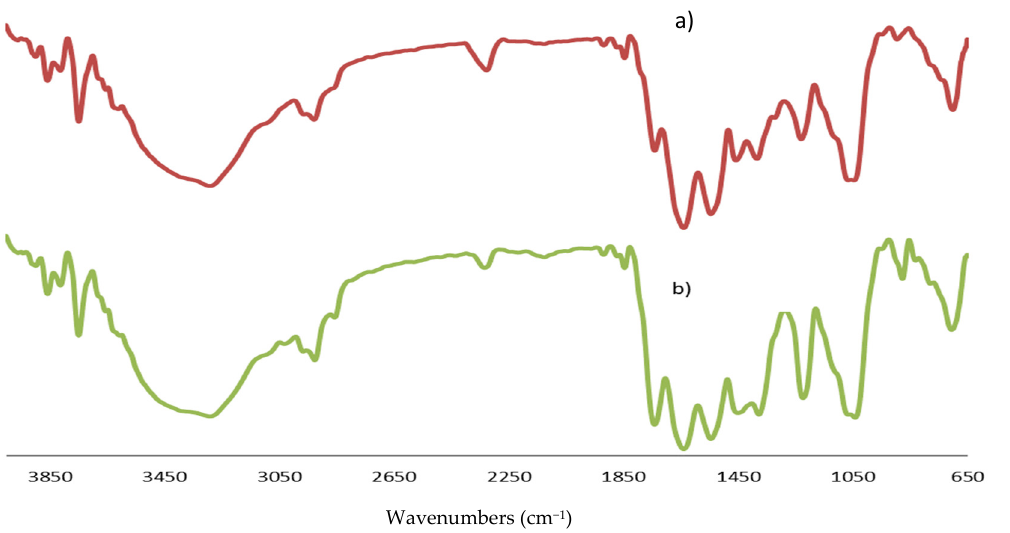
Figure 1. FTIR spectra of EBN ( a ) half cup and ( b ) stripe-shaped.